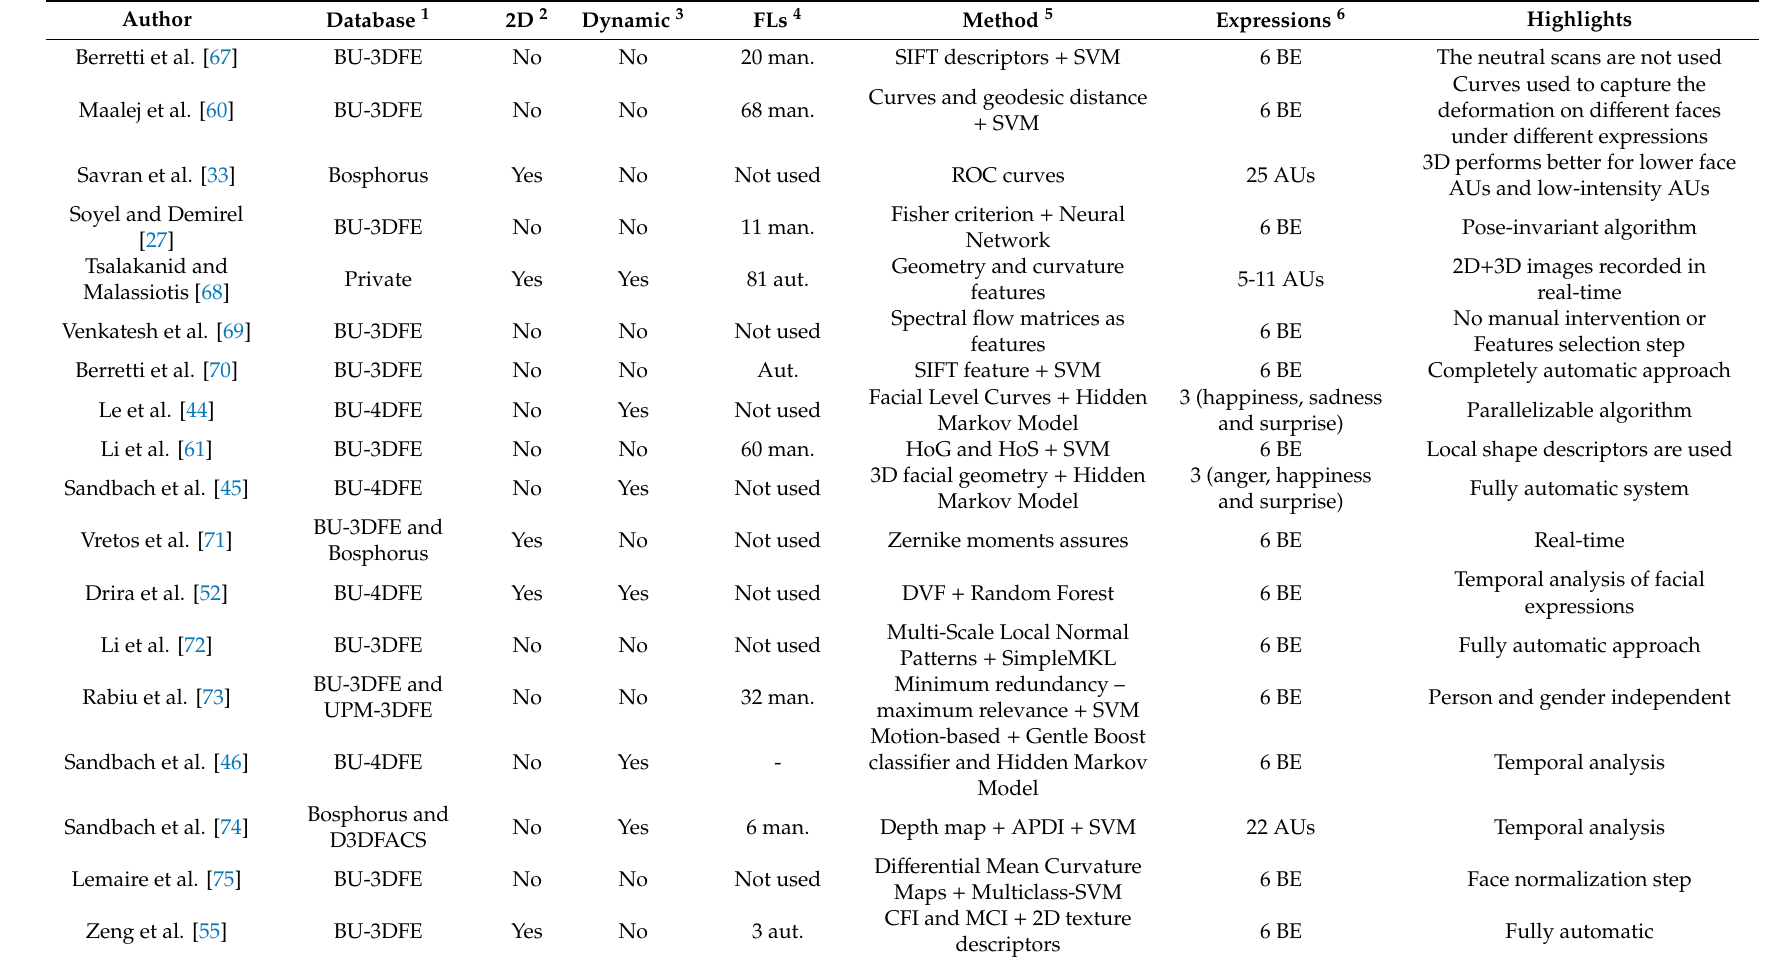
Table 2. Feature-based